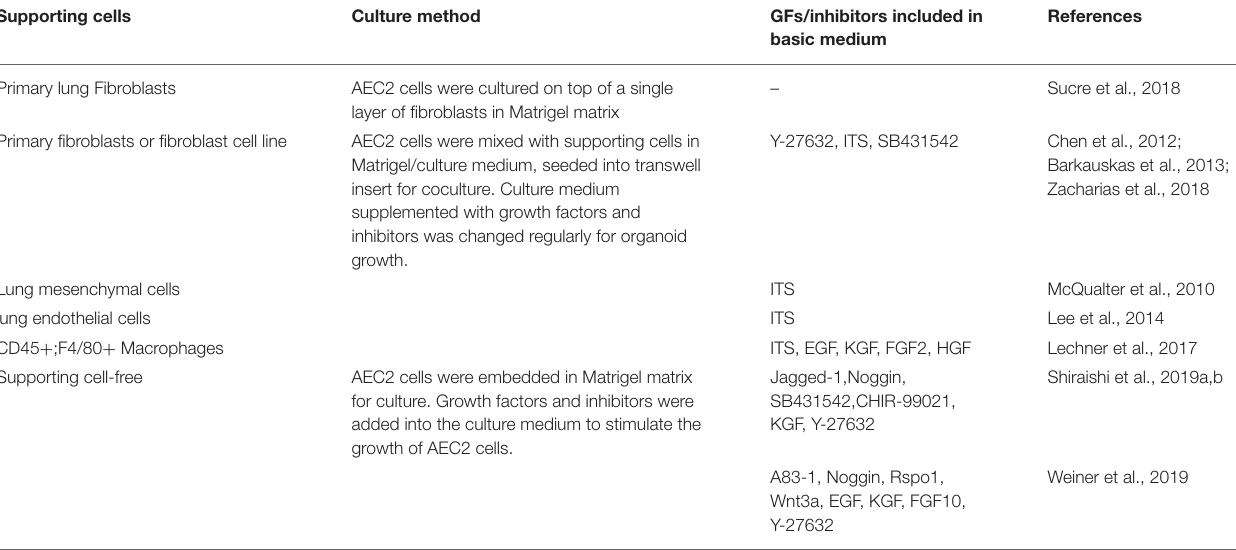
SUPPLEMENTARY TABLE 1 | Organotypic culture methods of AEC2